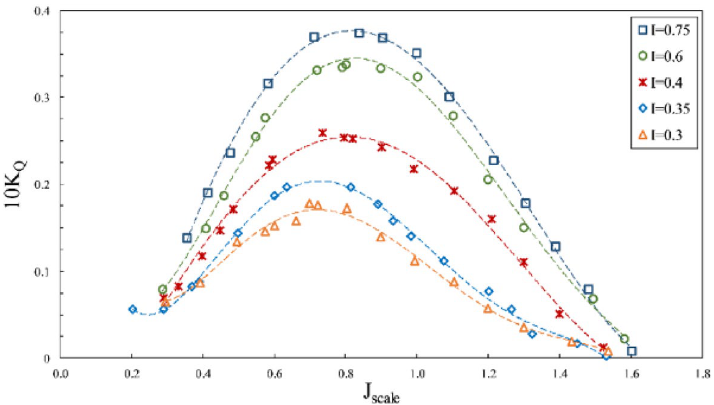
Figure 16. Effect of immersion ratio on the torque coefficient in the propeller direction ( α = 6 ◦ ).